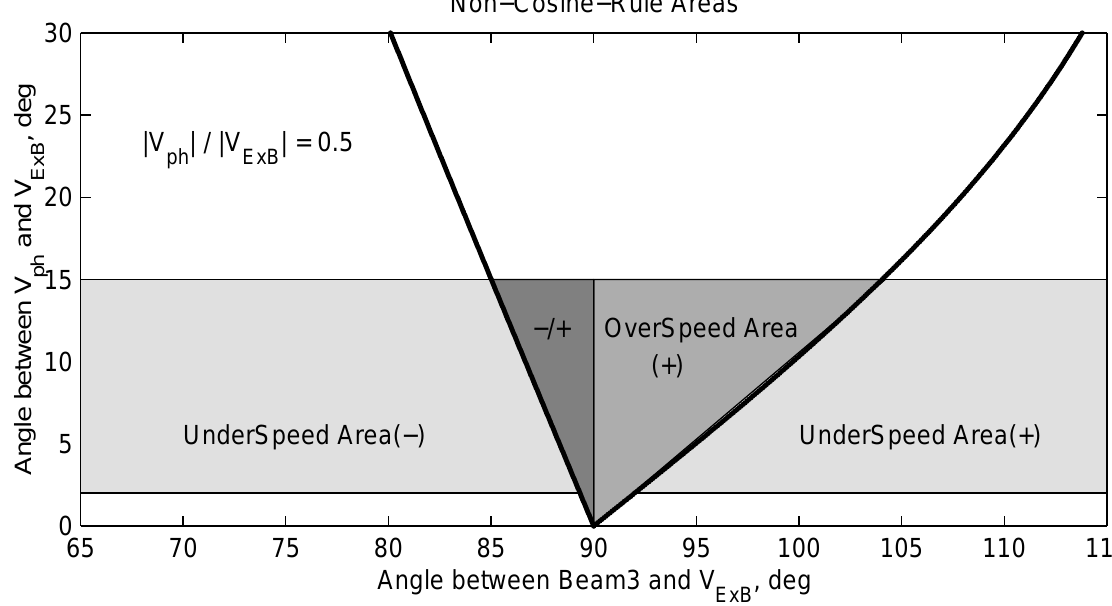
Fig. 9. Areas of applicability of the cosine rule for a EISCAT/STARE velocity ratio of | V ph | / | V E × B | = 0.5; the light shading covers two “underspeed” areas for the positive (+) and negative (-) Doppler velocity components and an expected range of the azimuth offsets between V E × B and V ph vectors; the darker shading is the “overspeed” area and the darkest shading is the area with opposite signs of the phase velocity and electron flow velocity